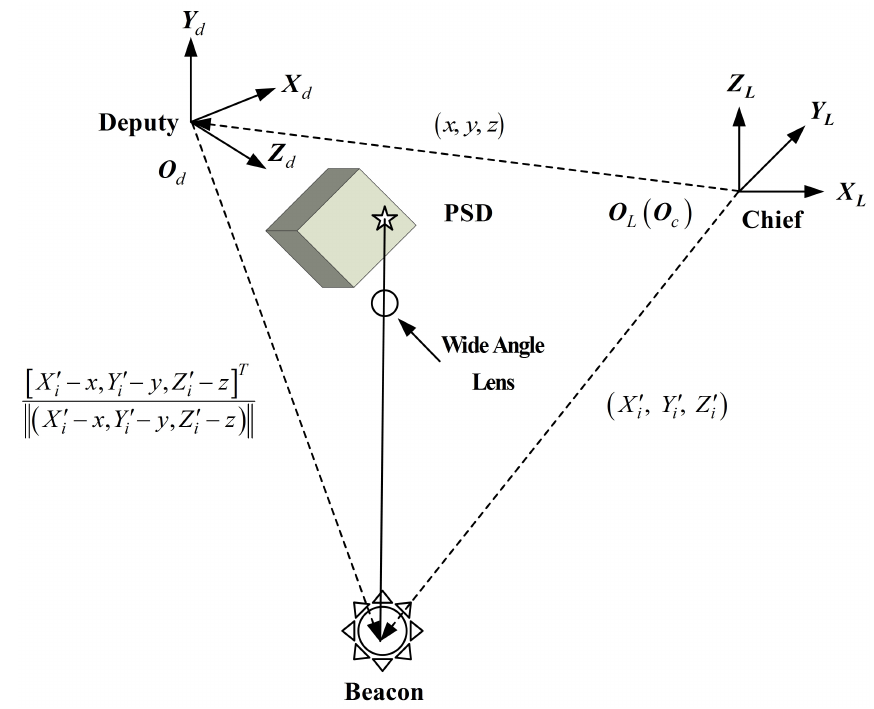
Figure 6. Vision-based navigation